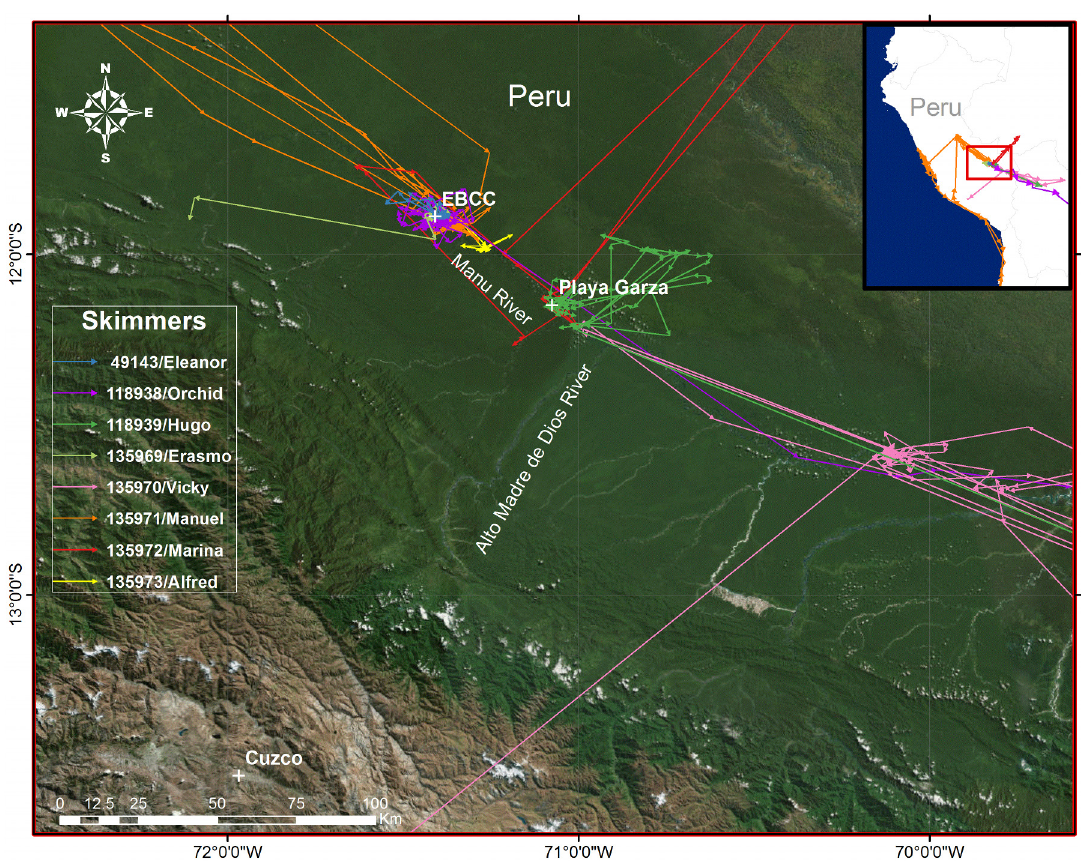
Fig 3. Regional movements of Black Skimmers from Manu National Park. Movements during the breeding season in the region of our two tagging sites: 1) the Cocha Cashu Biological Station (EBCC); and 2) Playa Garza, on the Manu River. Created with ESRI ArcGIS 10.2.2 software. Basemap data sources include: Esri, DigitalGlobe, GeoEye, Earthstar Geographics, CNES/Airbus DS, USDA, USGS, AEX, Getmapping, Aerogrid, IGN, IGP, swisstopo, and the GIS User Community.